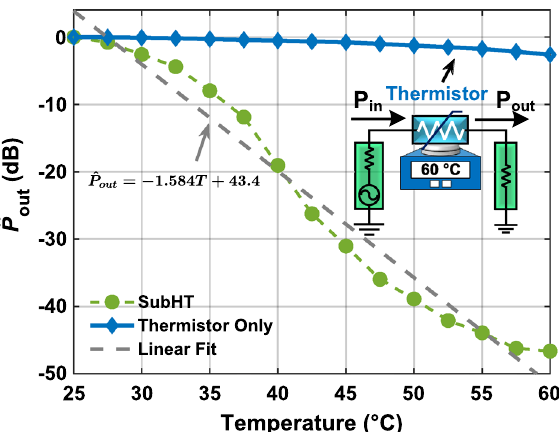
ˆ P out values attained by the ˆ P out versus T is shown (in gray) together with its